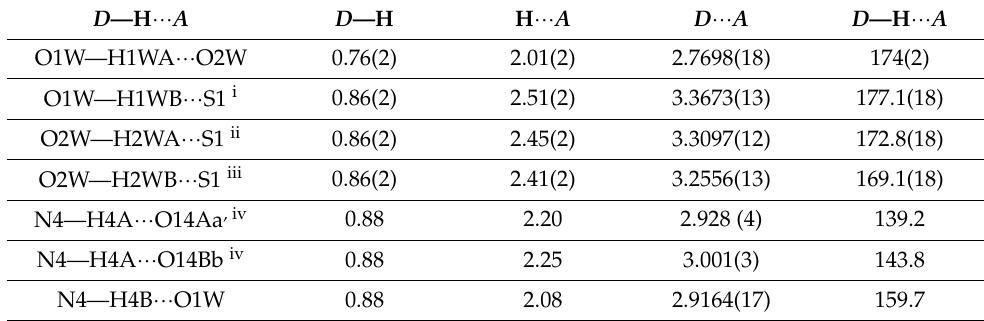
Table 11. Hydrogen-bond geometry (Å, ◦ ) for 9 .